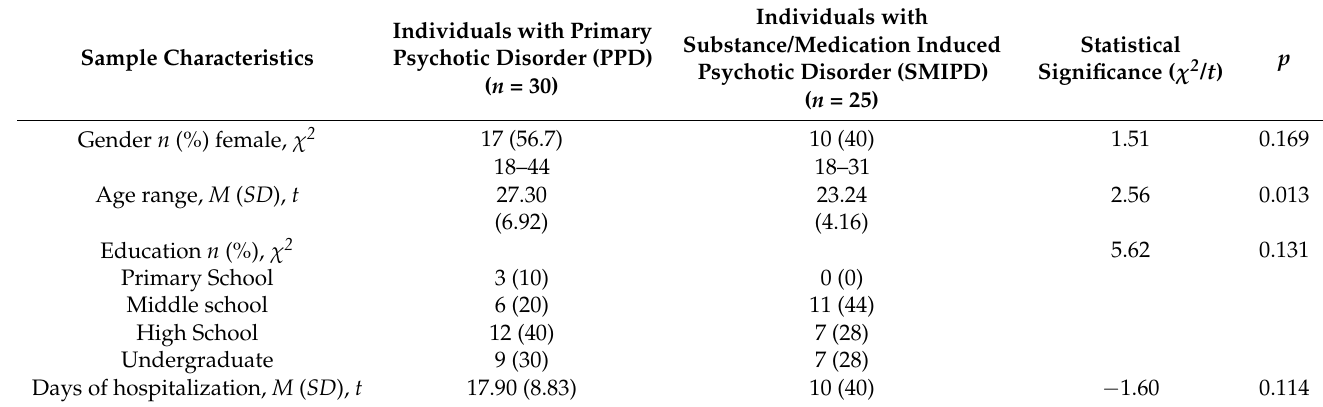
Table 1. Demographic Description of Characteristics of participants from PPD and SMIPD.